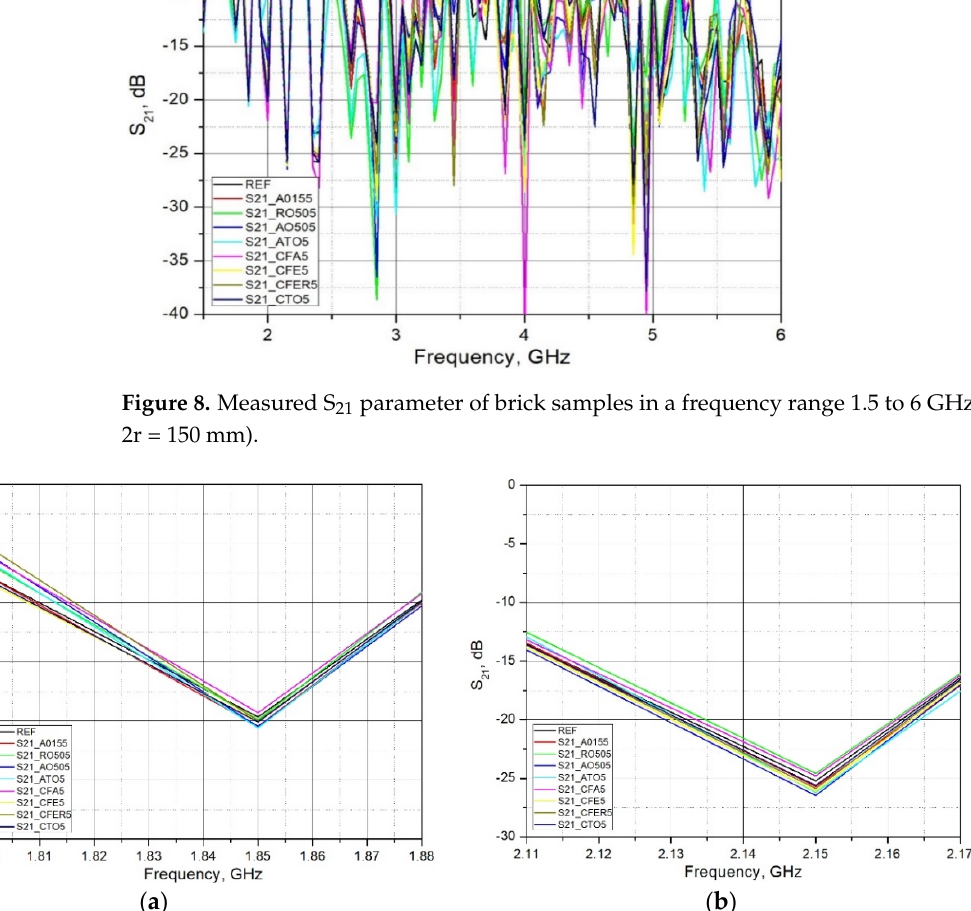
Figure 9. Measured S 21 parameter of brick samples for ( a ) LTE1800 in a frequency range 1.8 to 1.88 GHz; and ( b ) LTE2100 in a frequency range 2.11 to 2.17 GHz, (d = 18 mm; 2r = 150 mm).